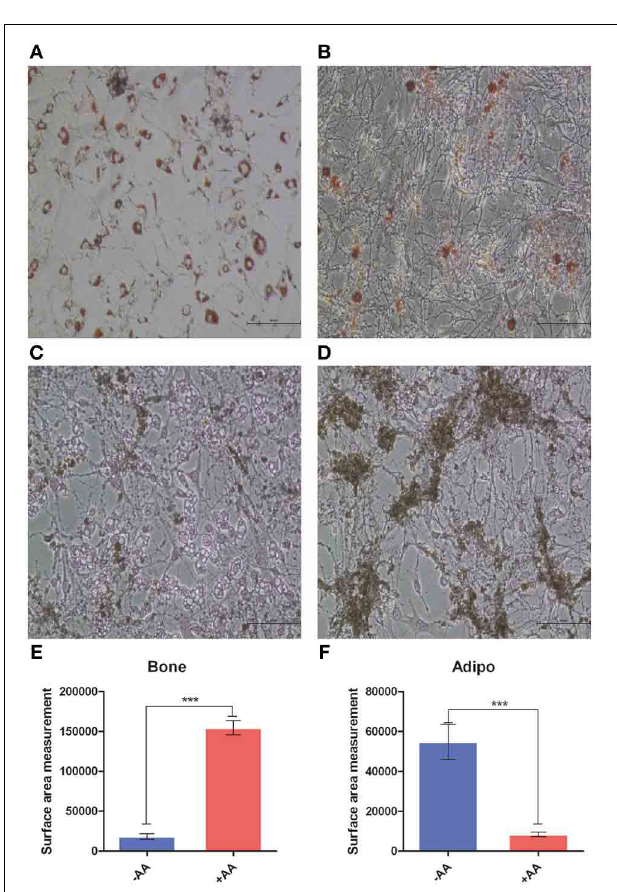
FIGURE 7 | OP9 cell differentiation. OP9 cells were cultured in a medium (see Materials and Methods) without AA (A,C) or with AA (B,D) . After 21 days, cells have been stained either with Oil Red O (A,B) or with Von Kossa Staining (C,D) . Pictures have been captured using a Zeiss light microscope. Surface of fields presenting Von Kossa staining (E) or Oil Red O staining (F) , was evaluated using ImageJ software package. ∗∗∗ p < 0 . 001.